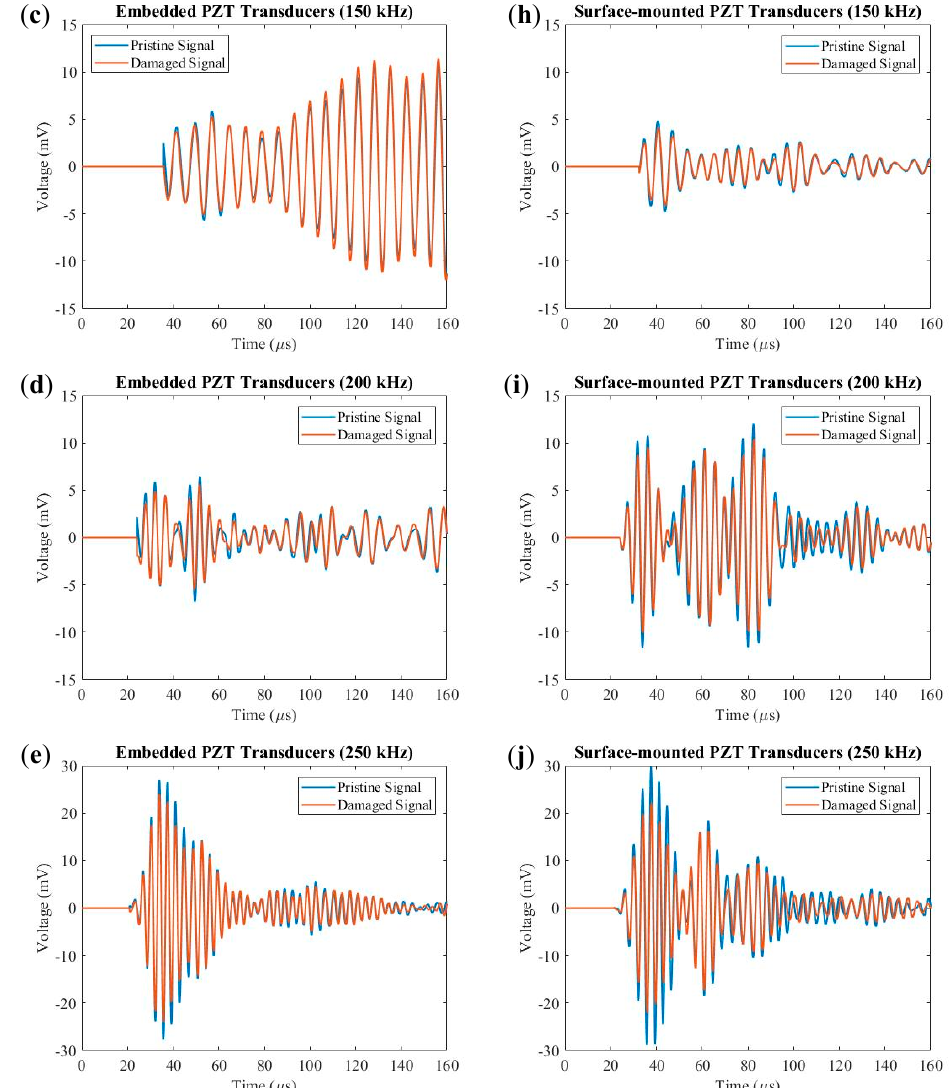
Figure 15. Signal comparisons between pristine and damage signals for ( a )–( e ) embedded and ( f )–( j ) surface ‐ mounted PZT transducers at 50–250 kHz.